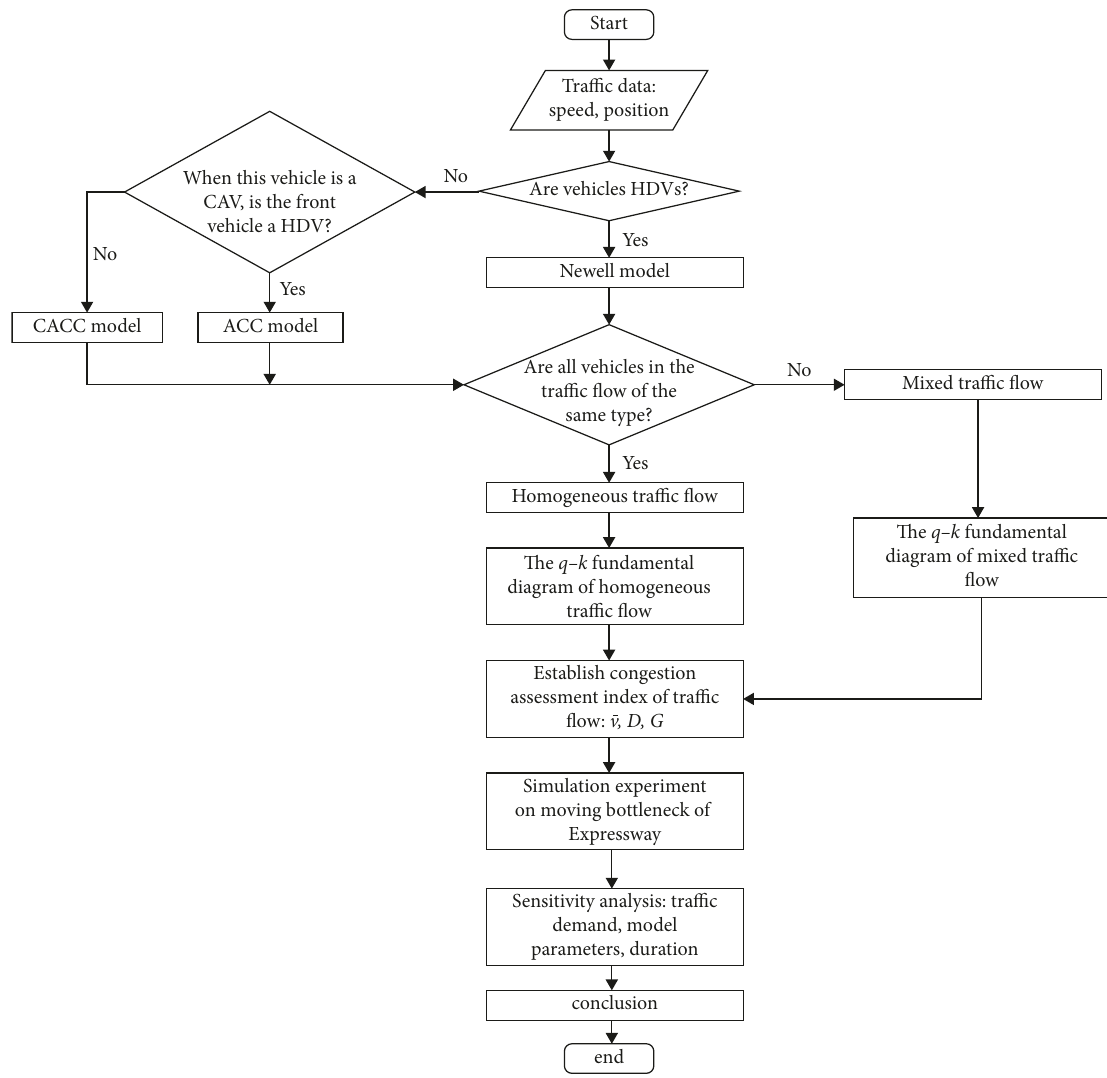
Figure 1: The framework of this paper.